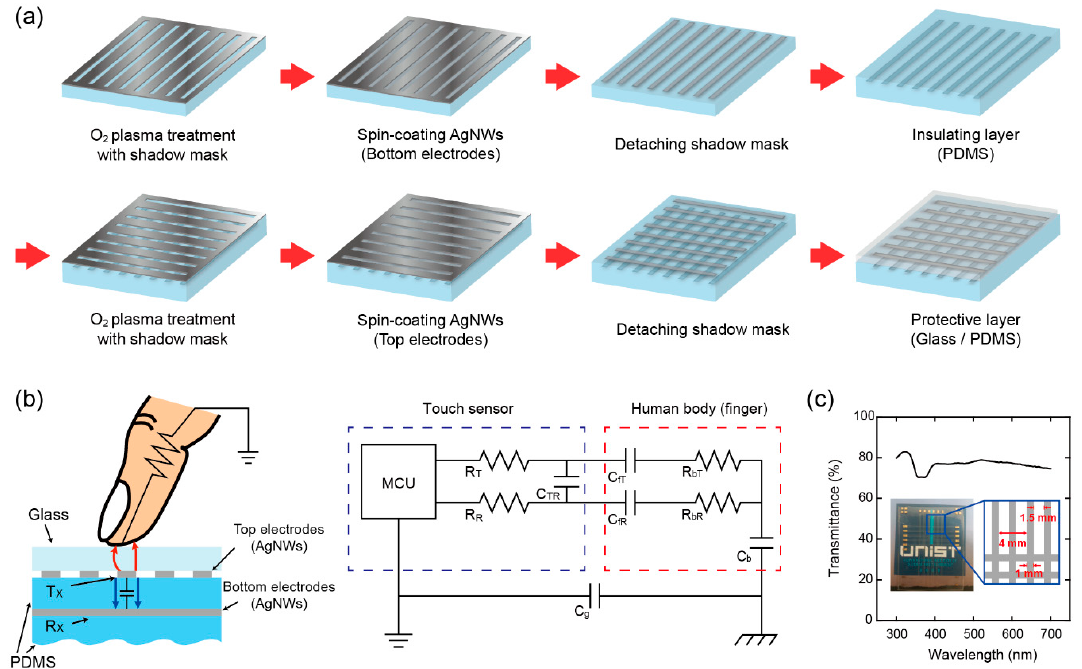
Figure 1. ( a ) Non-lithographic processes of fabricating touch screen panel (TSP). ( b ) Schematic view of the operational principle of fabricated TSP and its equivalent circuit. ( c ) The photo of fabricated TSP and its transmittance at the crossing area of top and bottom electrodes. The fabricated TSP has 6 × 6 crossed lines of top and bottom electrodes. The width of electrode (both top and bottom) is 1 mm and the spacing between electrodes is 1.5 mm.